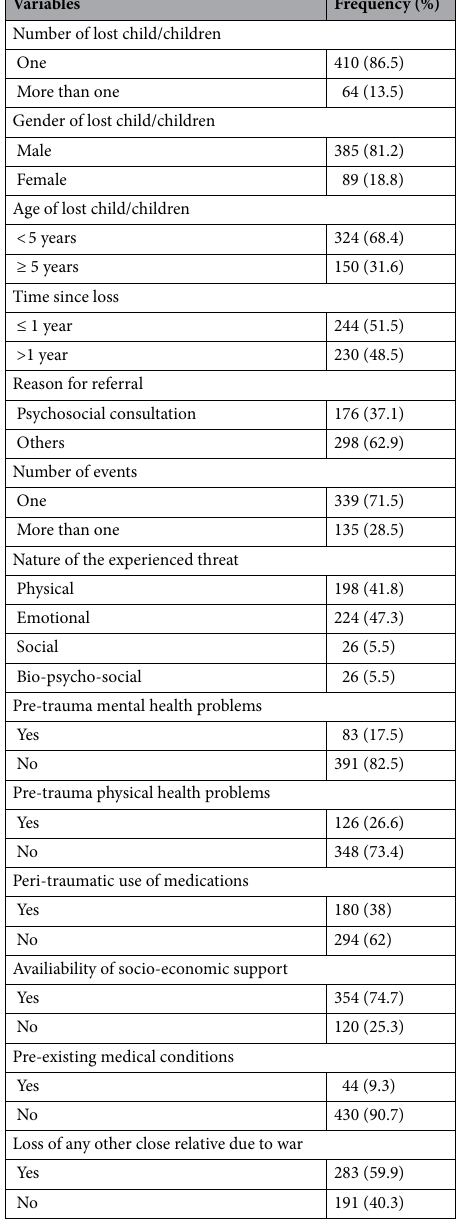
Table 2. Characteristics of the bereaved parents and the index trauma (N =